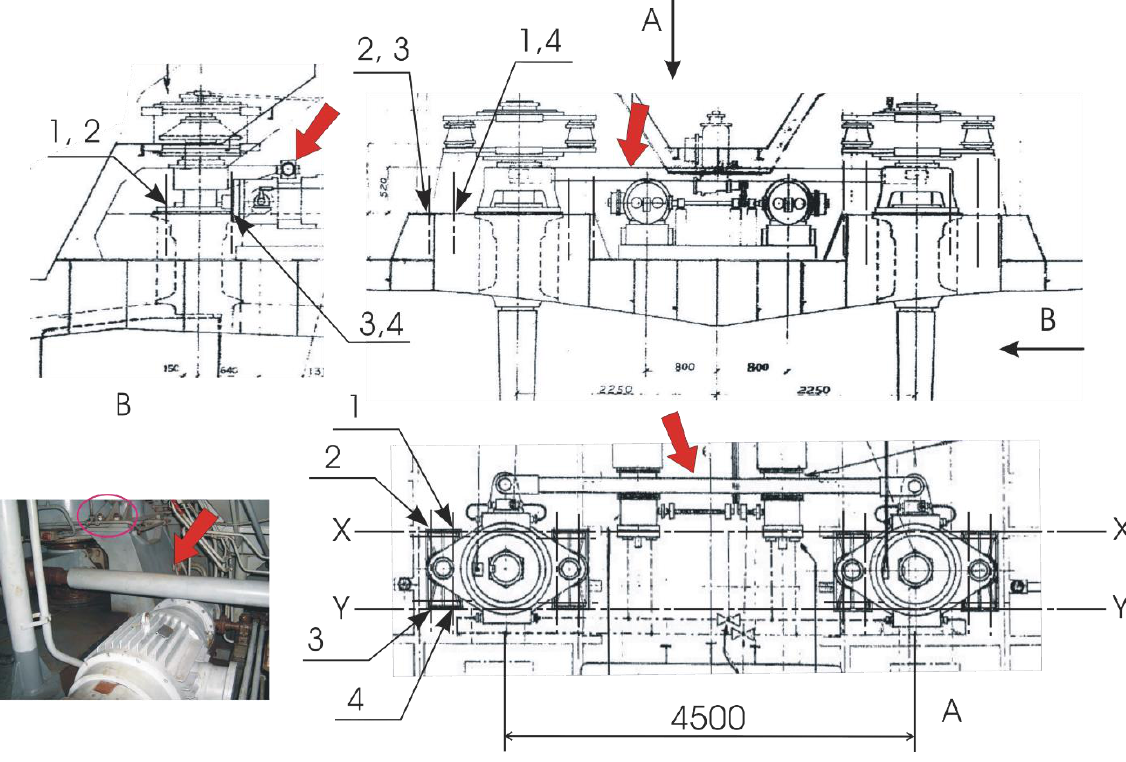
Figure 1: A twin rudder driving system of a military vessel based on oil-pressure rotary actuators (the red arrows indicate the rudder operat- ing levers).